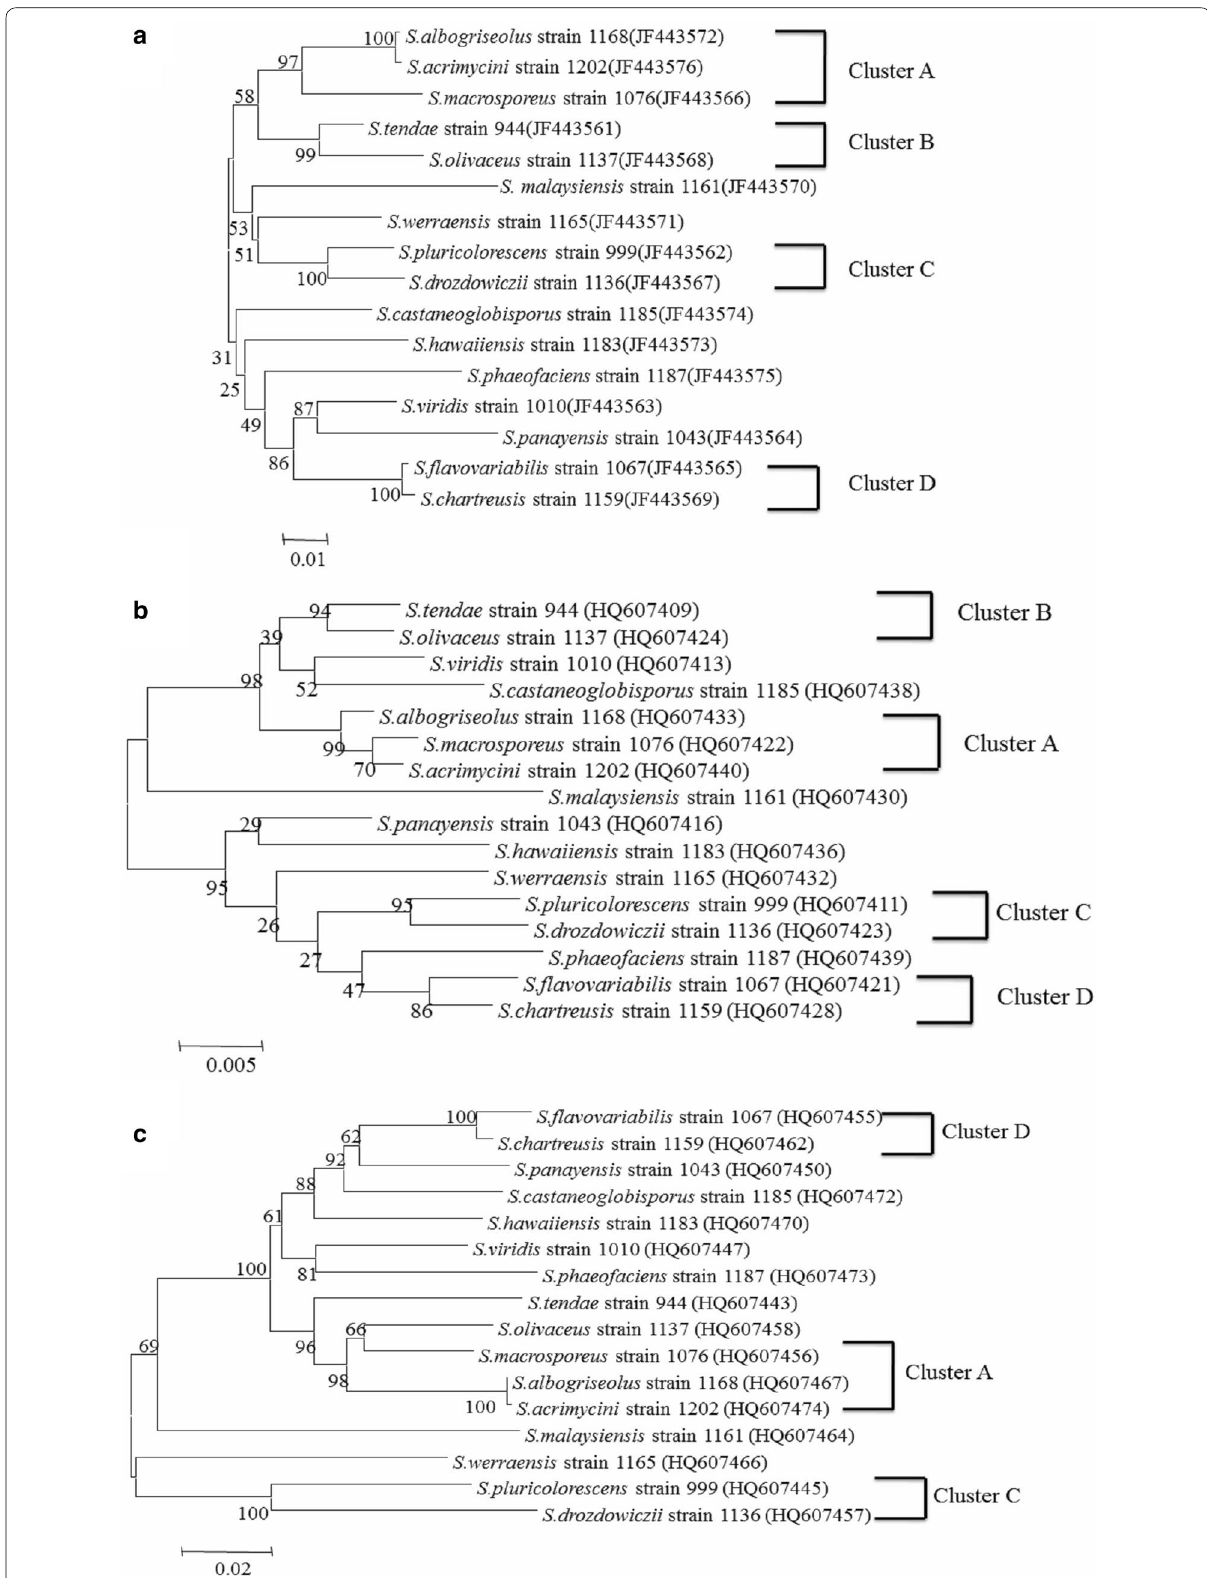
Fig. 3 Phylogenetic relationships based on the hsp70 ( a ), 16S rRNA ( b ) and gyrB ( c ) gene sequences of 16 Streptomyces